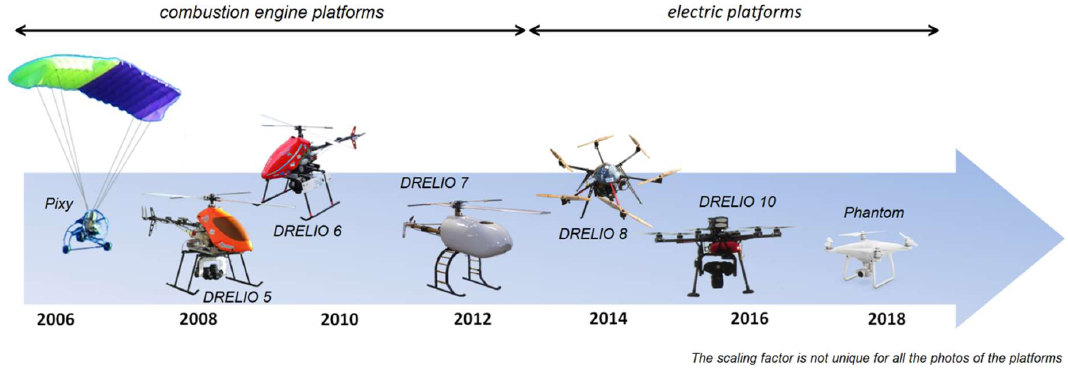
Figure 2. Evolution of the Unmanned Aerial Vehicles (UAV) platforms used for Porsmilin Beach monitoring. Table 1. Main characteristics of the different UAV platforms used for Porsmilin Beach monitoring. Characteristics Operating Range of mean Drone Camera period